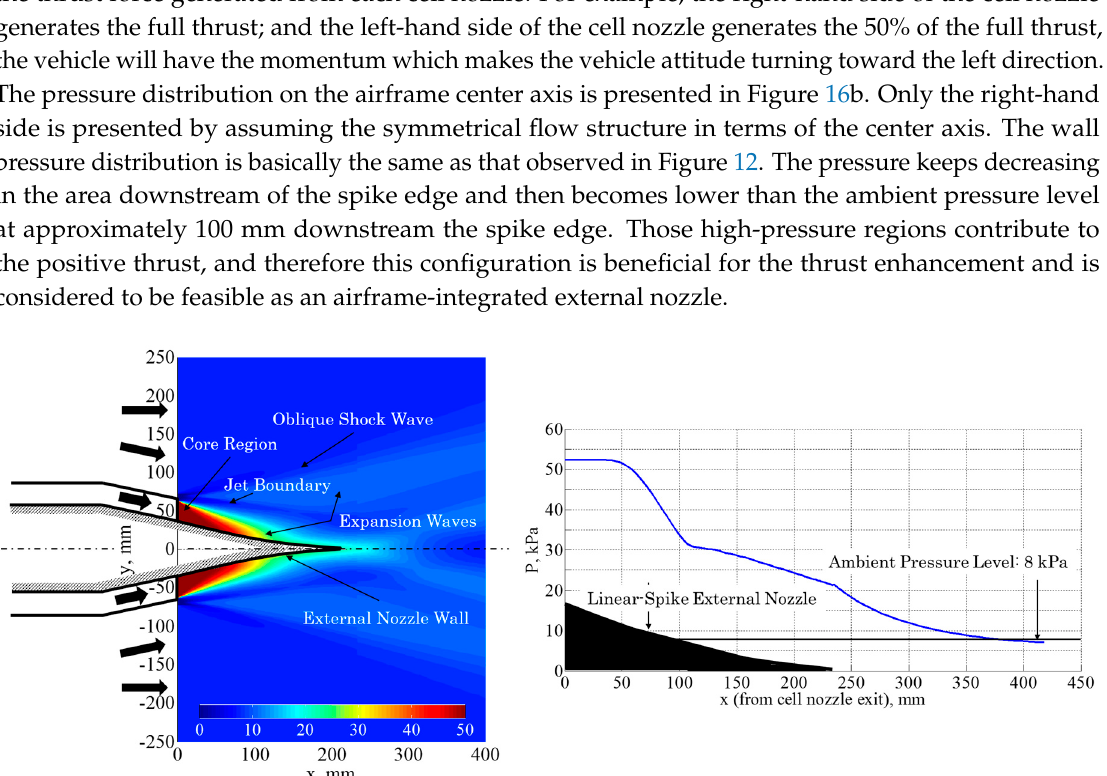
Figure 16. Flowfield characteristics of the advanced external-nozzle case showing the pressure distribution computed by the CFD. ( a ) Pressure contour map (Top-view) the color bar represents the static pressure in the unit of kPa; ( b ) Pressure distribution on the center axis.